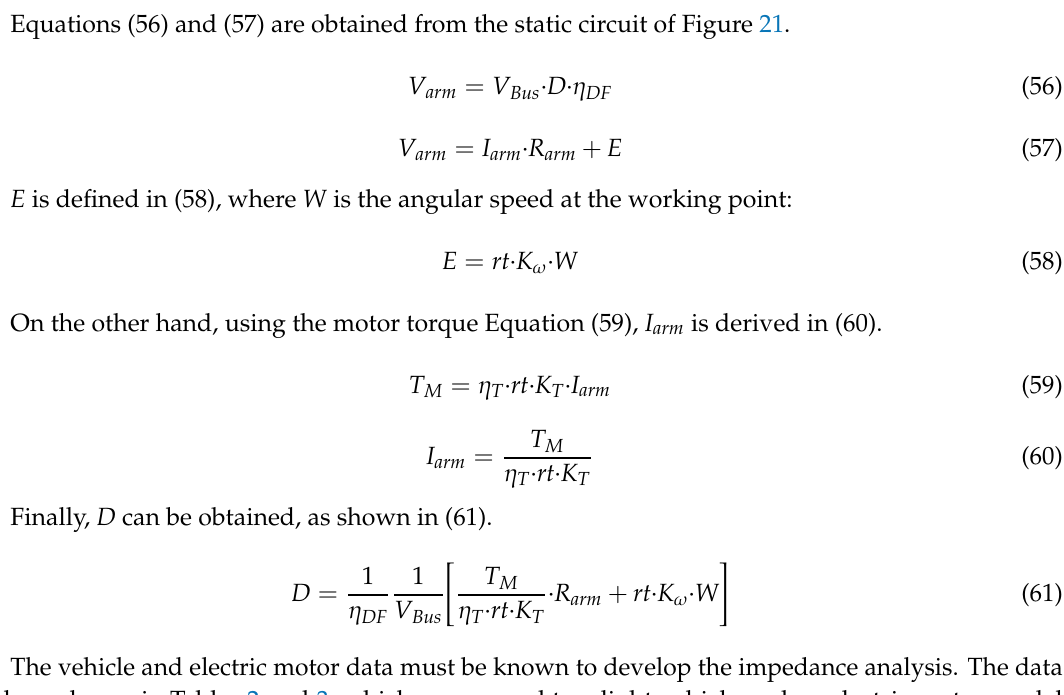
Table 2. Vehicle data. Reproduced with permission from [26].